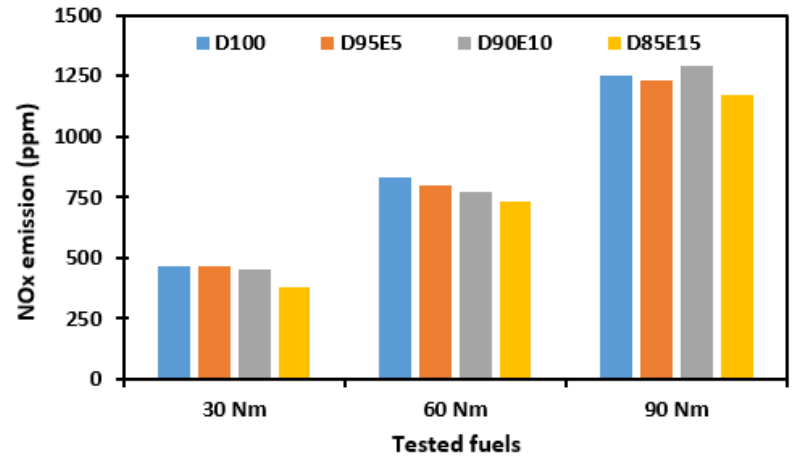
Figure 9. NOx emissions for all test fuels according to various engine